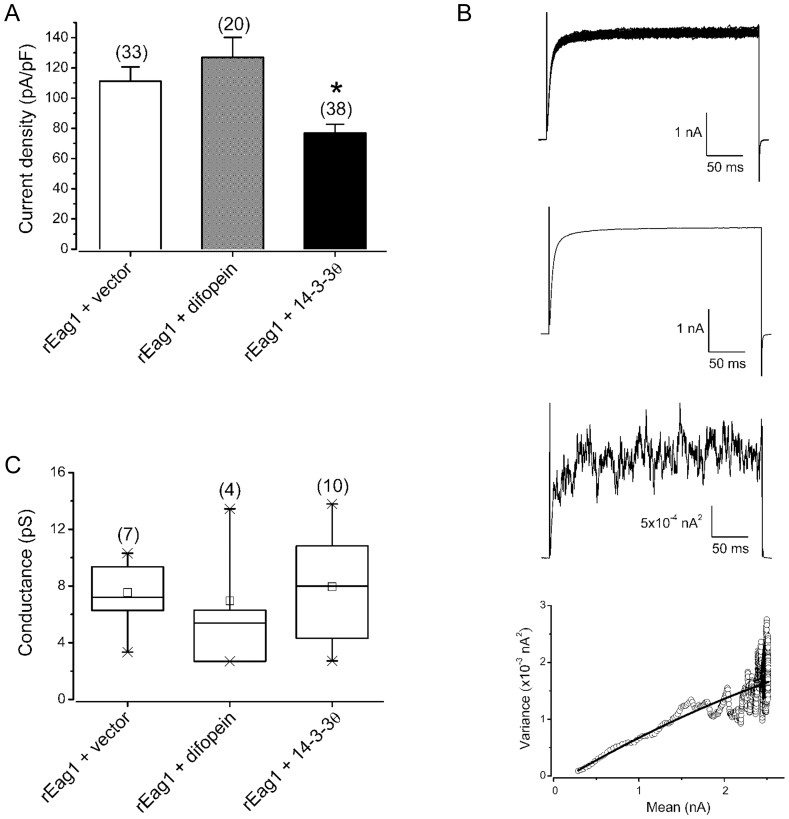
Estimation of the single channel conductance of rEag1 channel under different co-expression paradigms.rEag1 K+ channels were co-expressed with either the control vector, difopein, or 14-3-3θ in HEK293 cells. (
A
) Comparison of the mean current density (pA/pF) at +40 mV: rEag1+vector, 111.2±9.5; rEag1+difopein, 126.9±13.2; rEag1+14-3-3θ, 76.8±5.8. The numbers in the parentheses refer to the number of cells analyzed, and the asterisk denotes significant difference from the rEag1+vector control (*, t-test: p<0.05). (
B
) Representative non-stationary fluctuation analysis of rEag1 K+ currents. (Top row) Whole cell current traces were evoked by 300-ms depolarizations from −90 mV to +40 mV, which were used to generate the ensemble mean (second row) and variance (third row). (Bottom row) The mean-variance plot (during the 300-ms test pulse, with the linear capacitative component eliminated)(open circles) was fit with a parabolic function (solid curve) to estimate the single channel current (0.9 pA). (
C
) Box plot presentation of the distribution of the estimated single channel conductance. Mean values (pS): rEag1+vector, 7.5±0.9; rEag1+difopein, 7.0±2.3; rEag1+14-3-3θ, 8.0±1.1. No significant difference was found among the three co-expression conditions (One-way ANOVA: p>0.05).